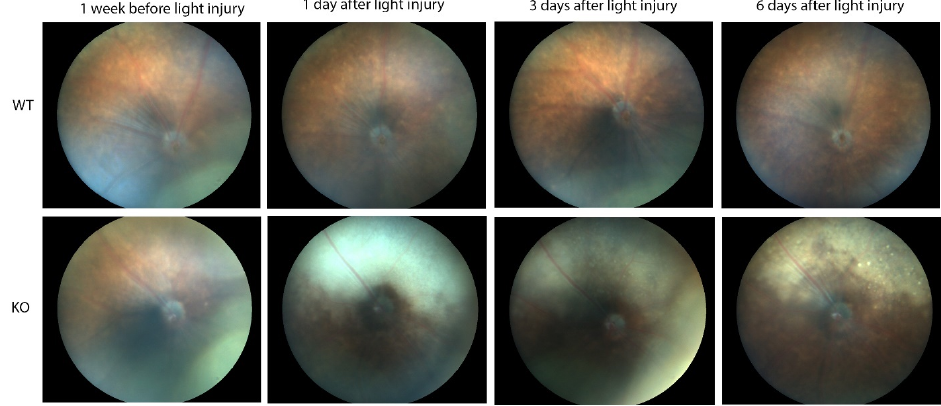
Figure 8. Fundus photographs showing light-induced injury in 17-month-old WT (10) and KO (6) mice. The time points are one week before light stress and one, three, and six days after light expo- sure.